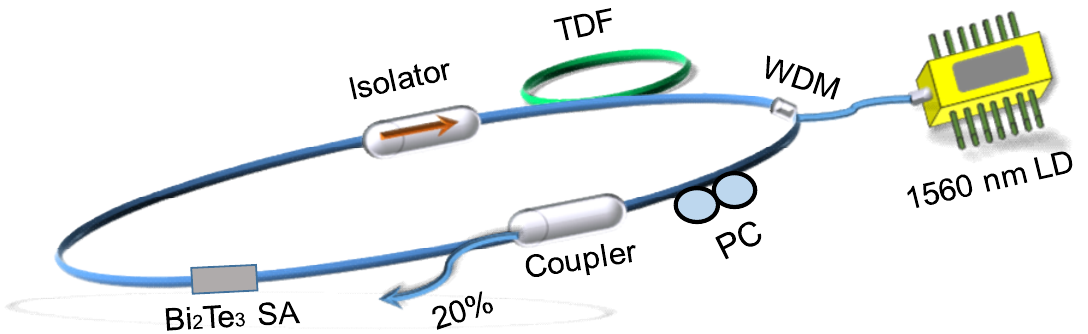
Figure 5. Experimental set-up for the thulium-doped fiber cavity.